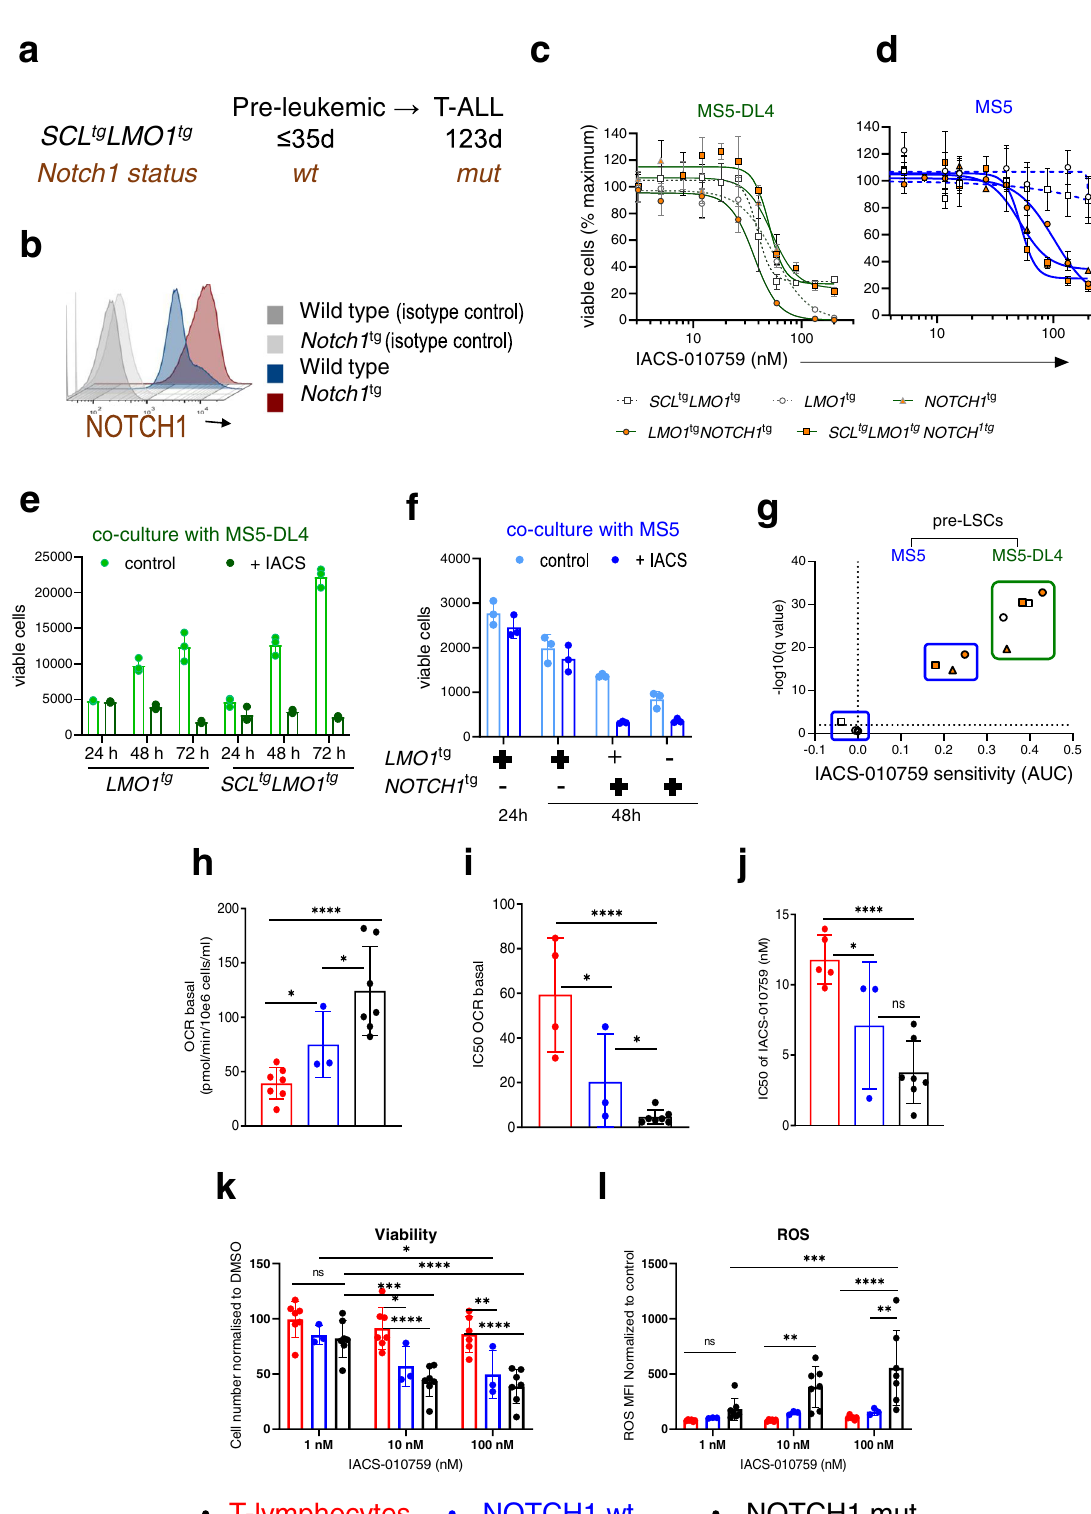
cultures exposed to DMSO whereas all three Notch1/IC genotypes cluster together, away from DMSO controls. Nonetheless, drug sensitivity remained lower compared to DL4-stimulated cells. Together with NOTCH1-occupancy of genes of the OxPhos pathway 35 (Fig. 1a), the response to OxPhos-i observed here suggests two levels of drug sensitivity: one directly regulated via NOTCH1 binding to OxPhos genes, and the other one associated